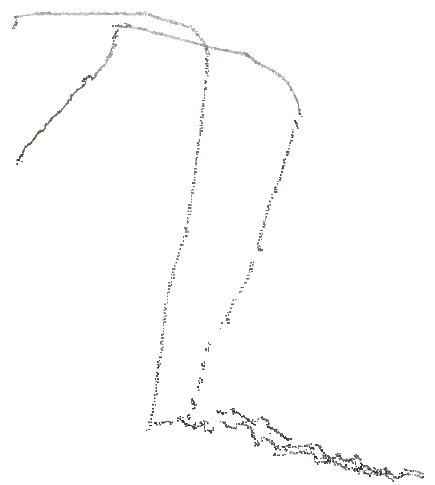
Figure 7. Profile of point clouds before / after movement